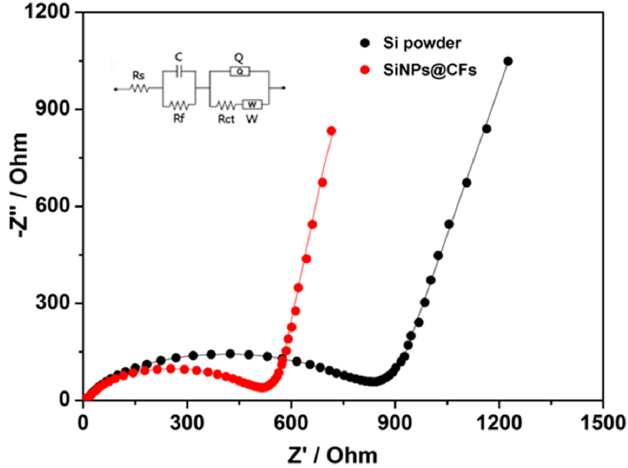
Figure 6 . EIS measurements of LIBs employing SiNPs@CFs and pure Si powder as anodes. Inset shows the equivalent circuit of the electrodes.